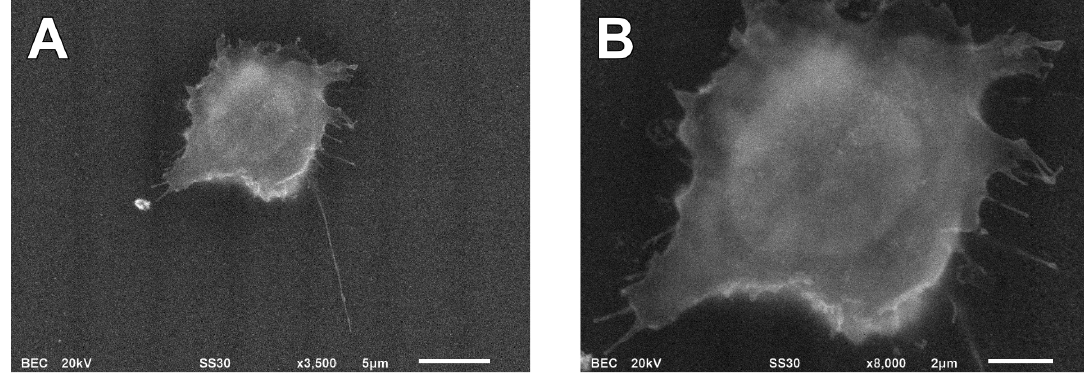
2.3. Ultrastructure of Lymphocyte Cell Surface Visualized by Positively Charged Gold Particles